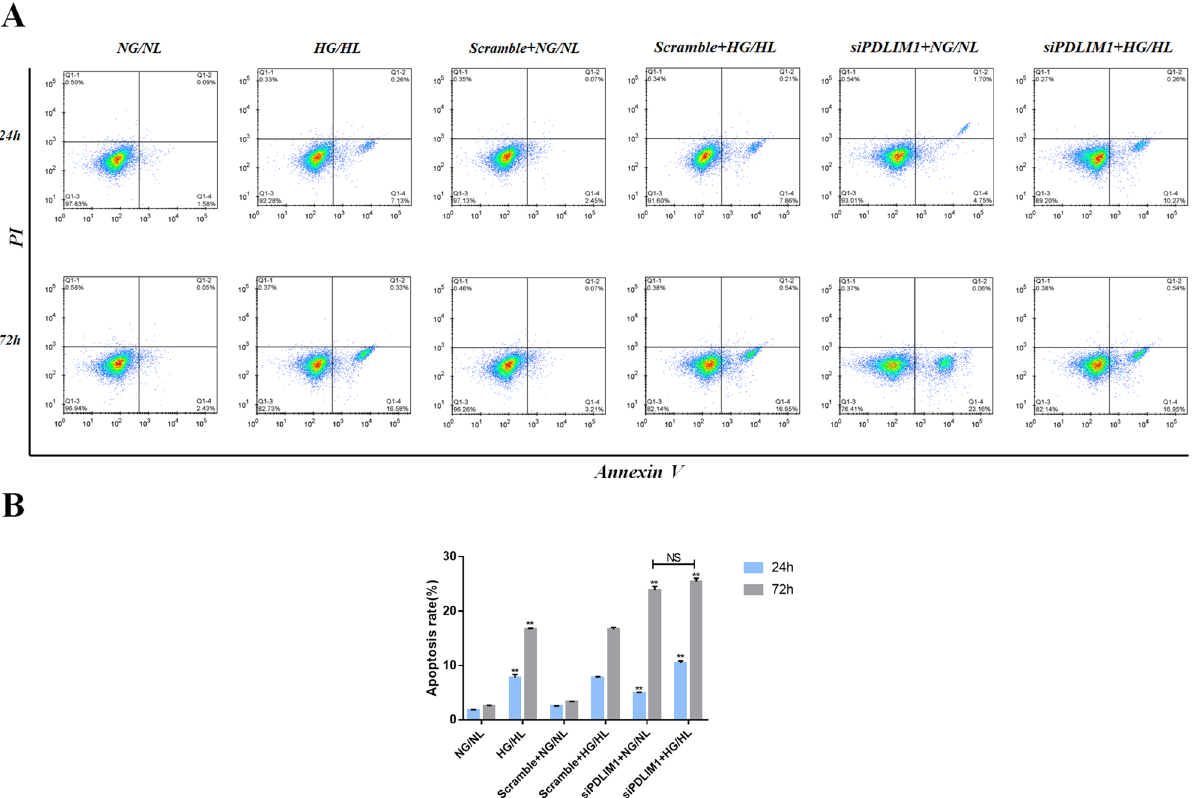
Figure 3. PDLIM1 reduces apoptosis of retinal capillary endothelial cells (RCECs) in DR. ( A ) Cell apoptosis rate was detected by flow cytometry. ( B ) At 24 h/72 h, apoptosis increased after HG/HL treatment,